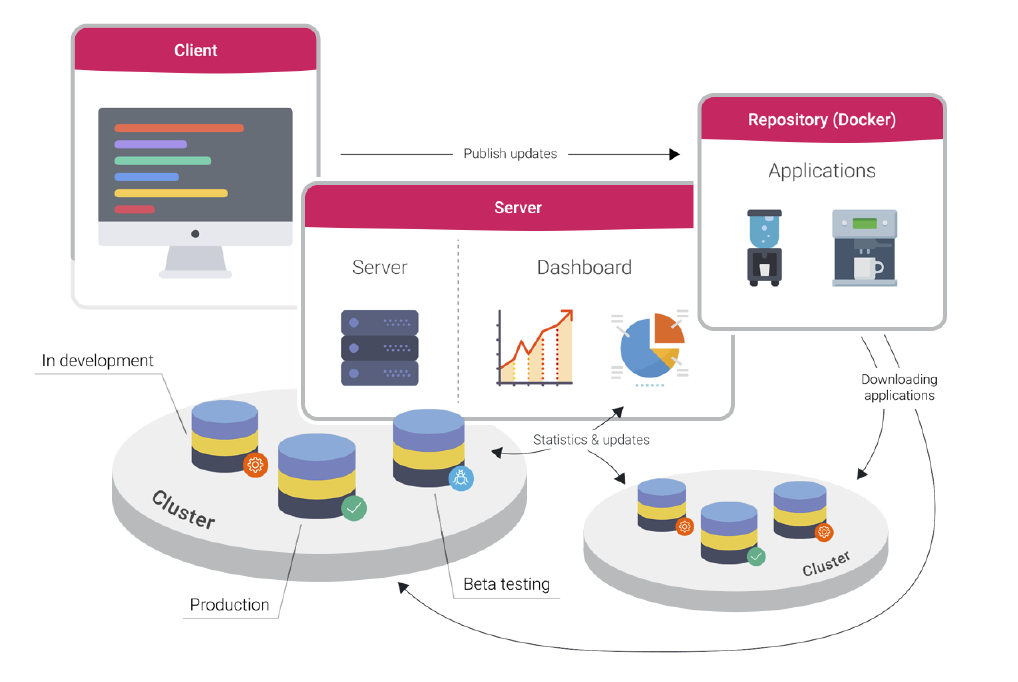
Figure 3. IoTWay system high-level